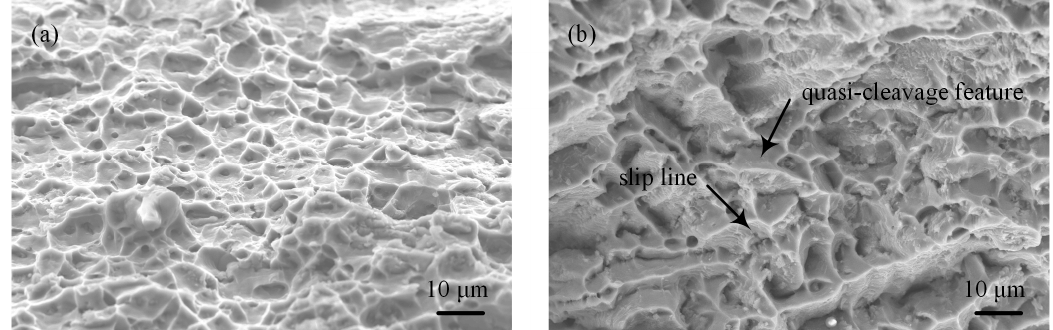
Figure 11. Fracture morphologies for the fracture surface of the hybrid welded joints. ( a ) Laser-CMT hybrid welded joint; ( b ) plasma-CMT hybrid welded joint.